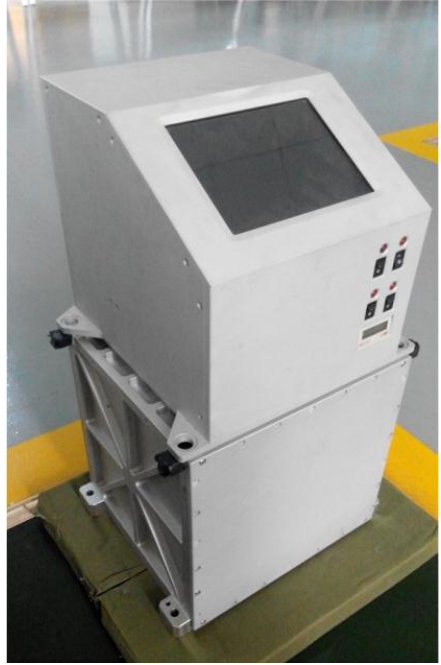
Figure 1. SGA-WZ02